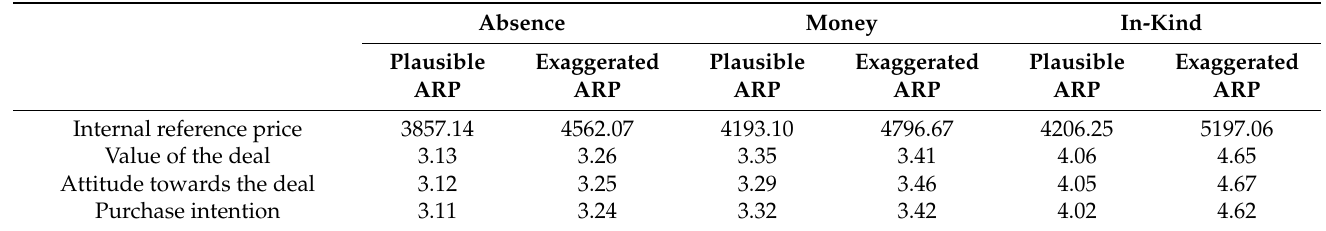
Table 2. Means of internal reference price, value of the deal, attitude towards the deal, and purchase